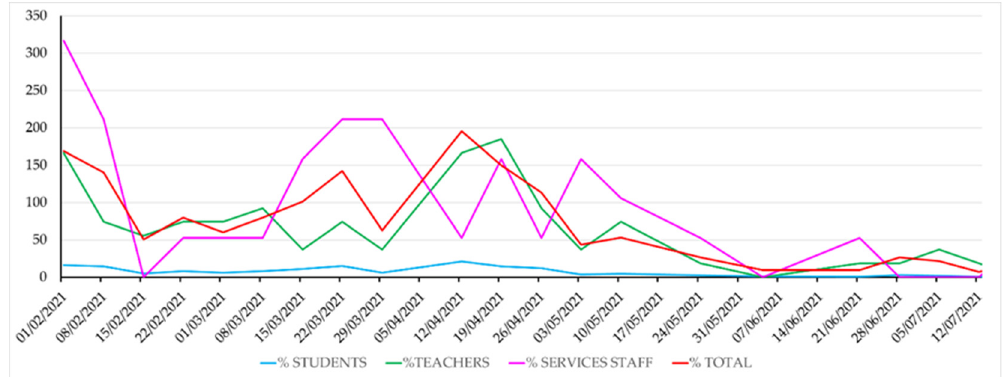
Figure 3. Evolution of the reported SARS-CoV-2 incidence in the studied period by group, in cases per 100.000 people.